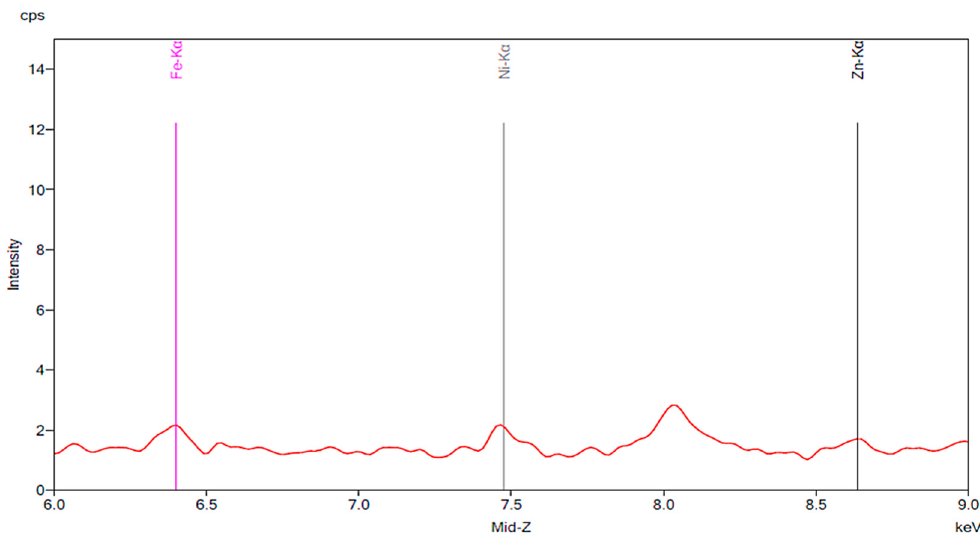
Figure 8. Baseline spectrum for a sample of black tea. The same parameters are used as those shown in Figures 2 and 5.